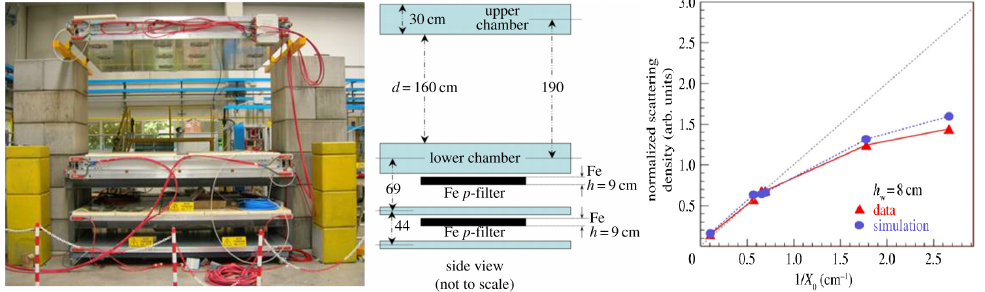
Figure 11. ( Left ): INFN muon tomography demonstrator; center: schematics of its composition; ( right ): reconstructed scattering density versus the expected value. Reproduced from